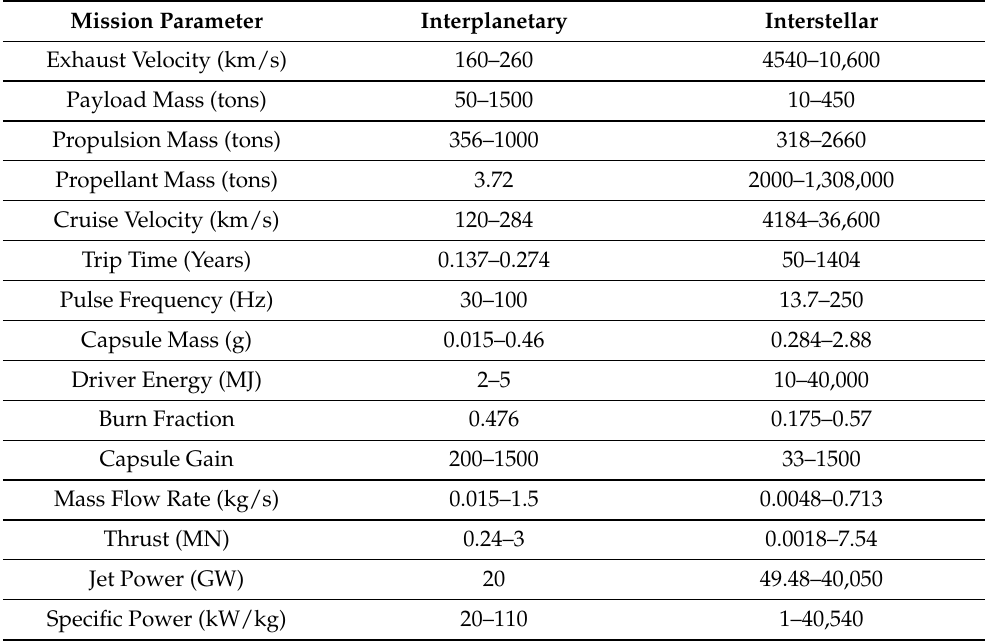
Table 5. Estimates for mission performance parameters for spacecraft concept designs applied to interplanetary and interstellar